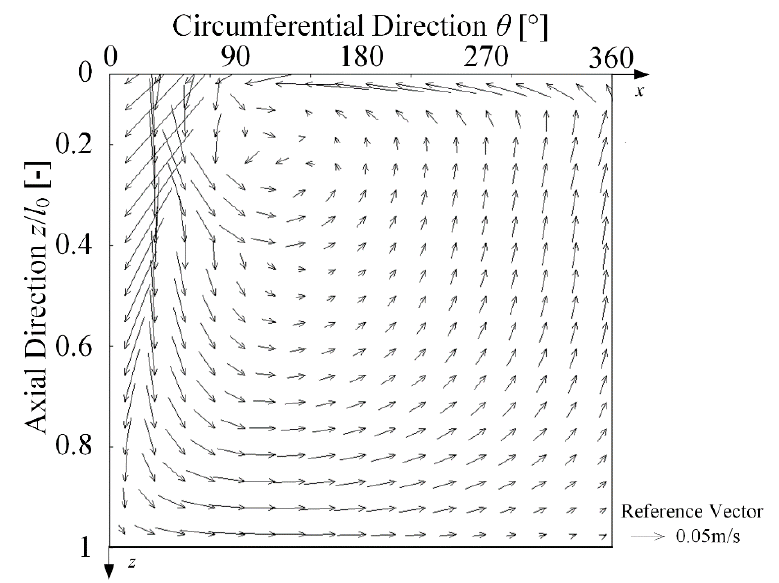
Figure 8. Velocity distribution.